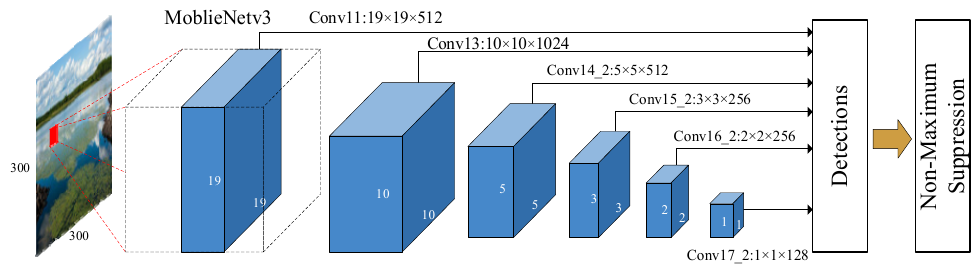
Figure 5. Network structure of SSD-MobileNetV3.